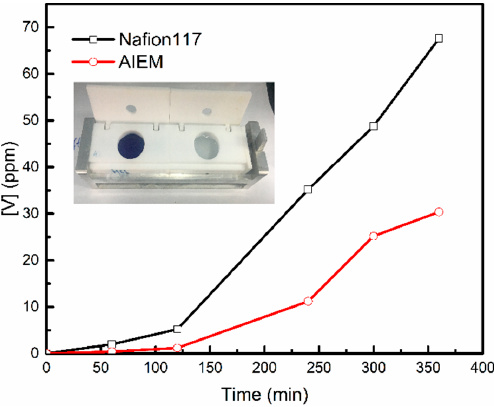
Figure 7. Permeability of V (IV) ions through the Nafion117 membrane and AIEM (GY = 40.9%).